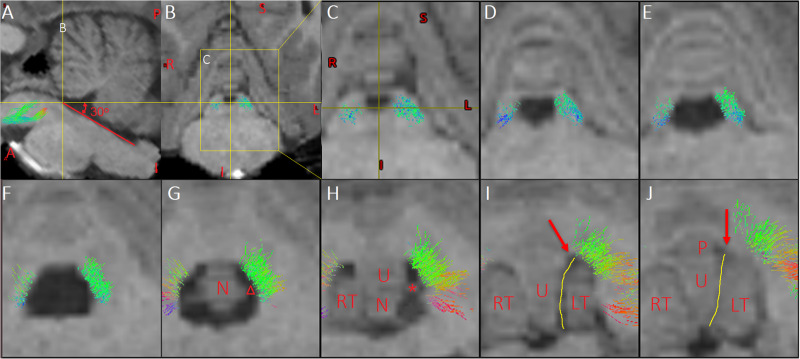
Multi-slice views of the pathway of Crus–Broca tracts related to the fourth ventricle and supratonsillar cleft. (A) In a sagittal slice, the focus point locates on the inferior border of the aqueduct. The angles between the yellow horizontal line and the red line superimposed over the floor of the fourth ventricle is about 30°, which is the mean operative angle of the telovelar approach (TeA) targeting the aqueduct reported in Figure 9B of one anatomical study (Tanriover et al., 2004). Line B demonstrates the coronal level of the coronal slice in (B). (B) The yellow box demonstrates the location of a slice in (C). (C–H) In the anatomical directionality from rostral to caudal, multi-slice views demonstrate the spatial relationship between the pathway of the Crus–Broca tracts and the fourth ventricle and supratonsillar cleft in the simulating angle of view of the TeA targeting the aqueduct. (I,J) Red arrows indicate the uvula–pyramidal junction which is the broadest strip of vermis and limits the lateral retraction of the tonsils and the operative angle of the TeA. The yellow lines indicate the uvulotonsillar cleft ending superiorly at the uvula–pyramidal junction, which is often opened to resect large tumors in the rostral part of the fourth ventricle (Rajesh et al., 2007). (G,H) After the opening the uvulotonsillar cleft, the lateral retraction of the tonsils and the medial retraction of the uvula and the nodule, one entryway to the rostral, dorsal, and lateral aspects of the fourth ventricle is obtained through the supratonsillar cleft (indicated by “△”). Of note is that, in these two slices, the pathway is next to the lateral bank of the entryway. The asterisk indicates the superior pole of the left tonsil (C–G). These streamlines next to the superolateral roof of the fourth ventricle should be protected from damage during tumor resection. LT, left tonsil; N, nodule; P, pyramid; RT, right tonsil; U, uvula.